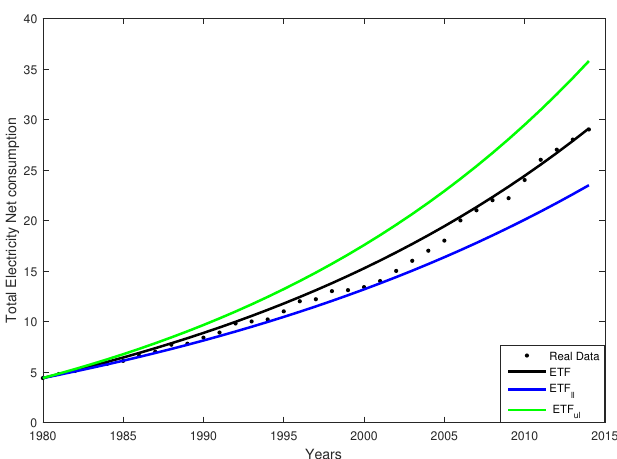
Figure 1. The real data versus those fitted by the Estimated Trend Function (ETF), the ETF ll , and the ETF ul .